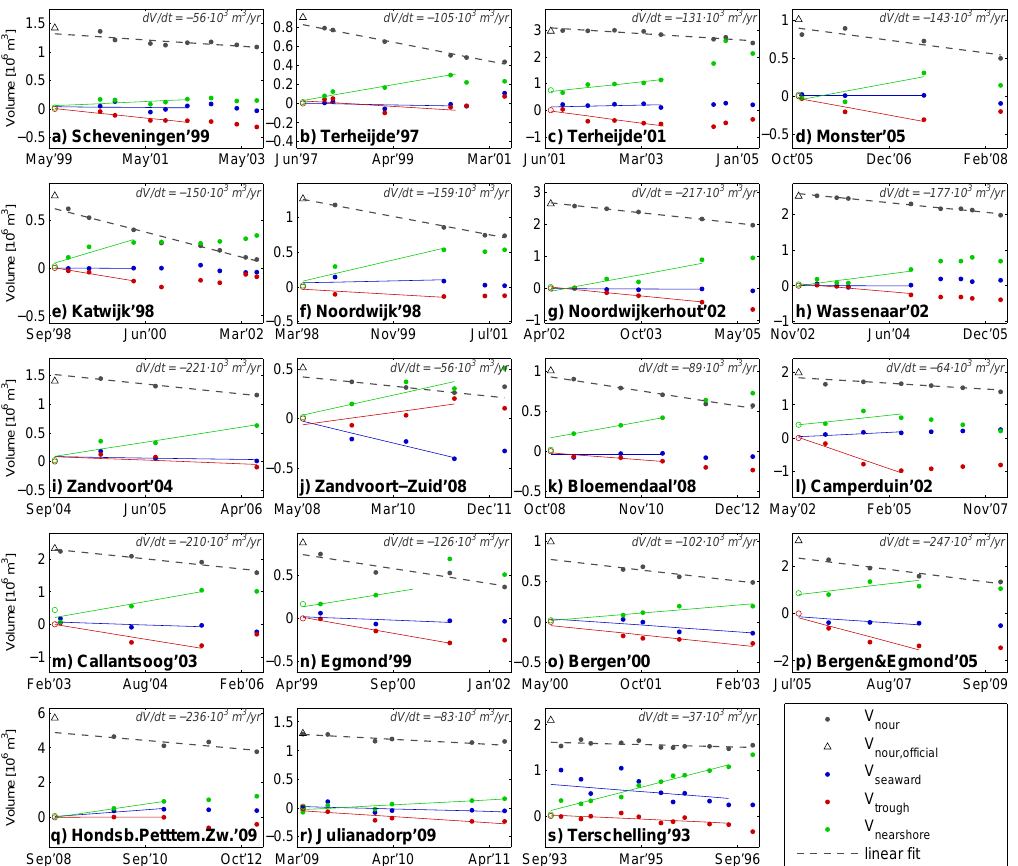
Figure 8. Overview of measured volume change after implementation of the 19 considered nourishments. The measured volume change is shown in each of the subplots with markers for the initial nourishment region (gray marker), the trough region in the first 120 m directly landward of the nourishment (red marker), the shallow nearshore region (green marker) and the offshore region (blue marker). A linear trend is fitted through the measured volumes in the initial nourishment region (presented as a dashed gray line) and for the first three-year development of the other regions (presented as colored lines). The long-term average volume change in the initial nourishment region ( dV nour / dt ) is shown in each of the subplots. A triangle marker represents the official nourishment volume ( V nour , of ficial ) from Rijkswaterstaat